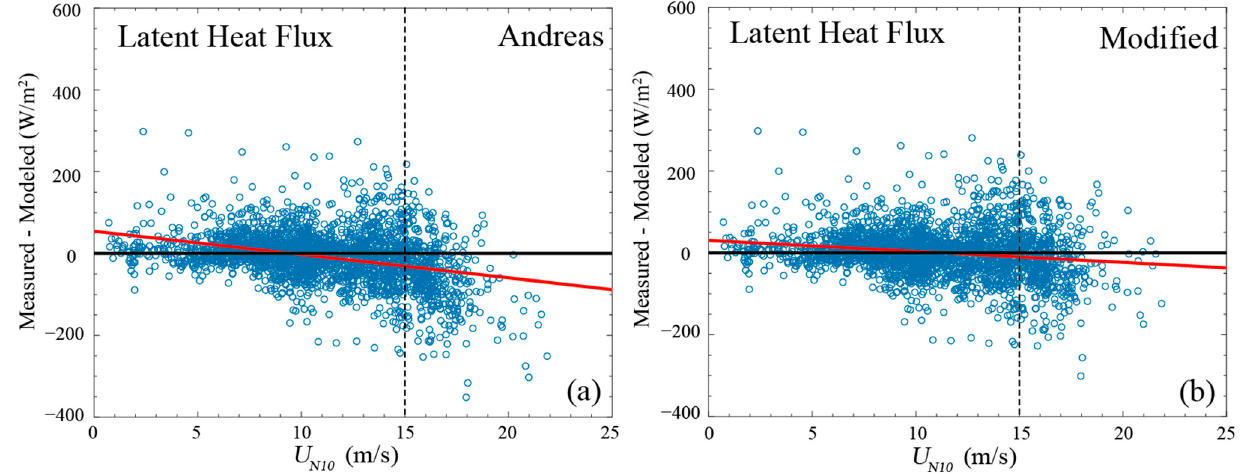
Figure 4. Comparison of the performance of the original and modified algorithms in the simulation of air–sea latent heat flux: ( a ) reflects the difference between the measurements and the modeled heat flux, including the sea spray-induced heat flux calculated by the AN15 algorithm; ( b ) also reflects the difference between the measurements and modeled results, but, here, the sea spray-induced heat fluxes are calculated by the modified algorithm. The independent variable is the 10 m, neutral-stability wind speed U N 10 . The difference between this and U 10 is notable. The ordinate represents the difference between the measurements and the modeled values. The black solid line represents the modeled values, which are equal to the observations. The red lines represent the least-squares fit to all data. The smaller the slope of the red line is, the better the effect on the model.